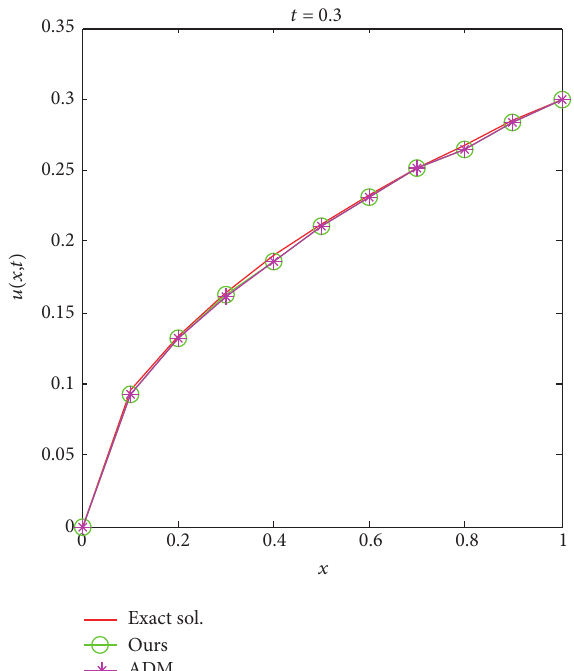
Figure 6: The comparison between FLFM and ADM with 𝑚 = 5, 𝑛 = 5 for Example